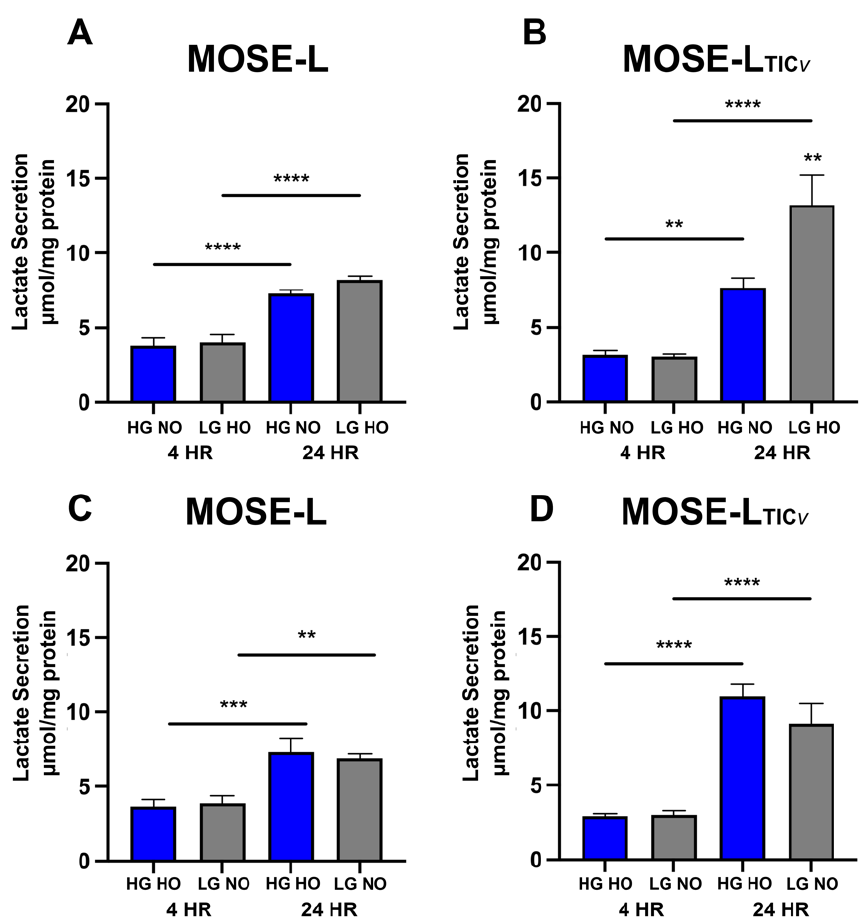
Figure 5. Lactate secretion of spheroids at 4 and 24 h of adhesion. Lactate secretion was measured in spheroids adherent for 4 or 24 h in optimal (HG NO) and limiting (LG HO) conditions in ( A ) MOSE-L and ( B ) MOSE-L TIC v as well as HG HO and LG NO in ( C ) MOSE-L and ( D ) MOSE-L TIC v spheroids. Data are represented as the mean ± SEM. ** p < 0.01 compared to HG NO; bars with ** p < 0.01 compared to 4 h; bars with *** p < 0.001 compared to 4 h; bars with **** p < 0.0001 compared to 4 h. Abbreviations: high glucose (HG); low glucose (LG); normoxia (NO); hypoxia (HO).